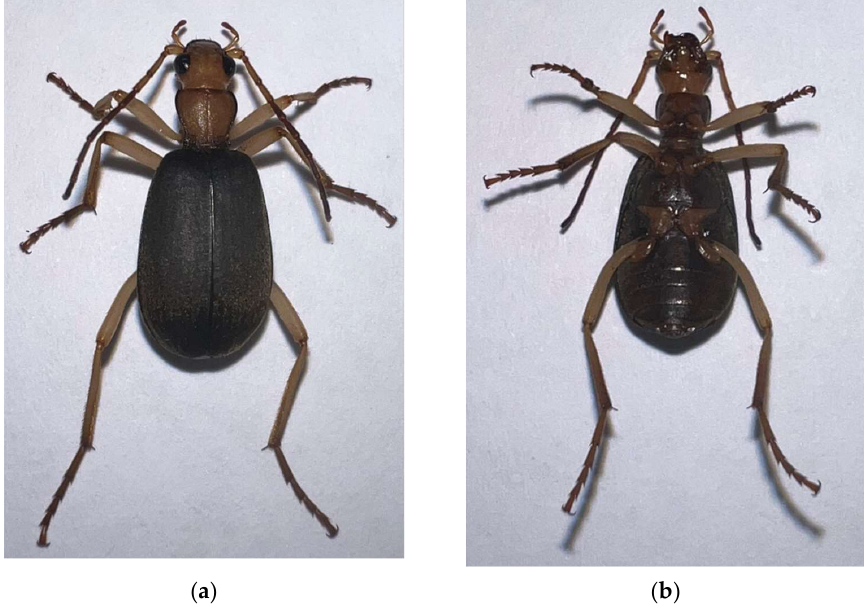
Figure 1. Species reference image of Galerita orientalis Schmidt-Göbel, 1846. ( a ) The dorsal view of G . orientalis ; ( b ) the ventral view of G . orientalis .